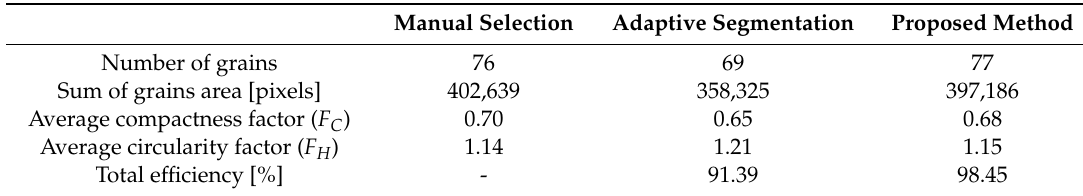
Table 2. Selected shape features for Figure 7 with fraction 0.1–0.2 mm.